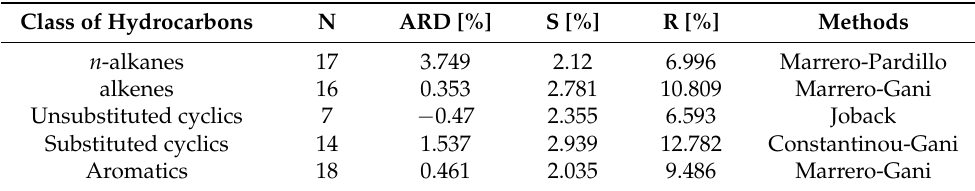
Table 7. Selected methods to predict the critical pressure (P c ) of hydrocarbons classes ( n -alkanes, alkenes, unsubstituted cyclics, substituted cyclics, and aromatics), of all the compounds present in OLP, obtained by thermal catalytic cracking of palm oil at 450 ◦ C, 1.0 atmosphere, with 10% (wt.) Na 2 CO 3